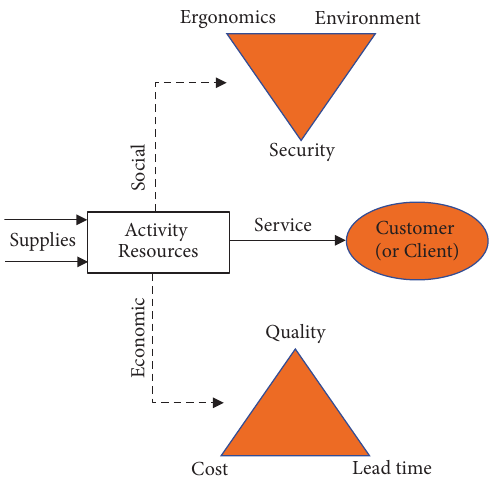
Figure 3: New performance concept “Technical-Social